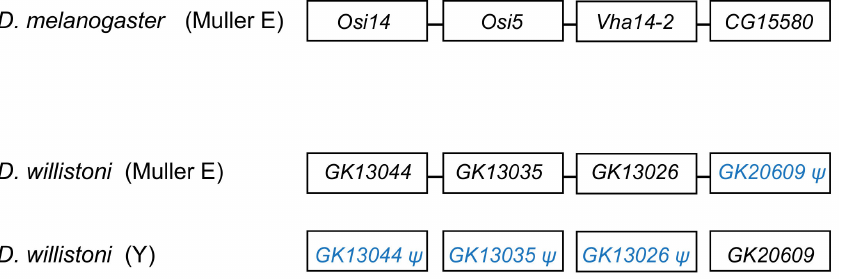
Figure 4. Fate of genes in the CH964272 segmental duplication. The segmental duplication copied 265 kb of autosomal sequence containing 25 genes to the Y chromosome of D. willistoni (for the sake of simplicity, the figure shows only four genes and omits several intervening ones). The Y- linked copy of GK20609 ( D. melanogaster ortholog: CG15580 ) remained functional, and the remaining 24 genes disappeared or became pseudogenes, whereas the opposite happened in the autosomal region. CG15580 / GK20609 and Vha14-2 / GK13026 are testis-specific genes in both species. The D. willistoni autosomal region is syntenic with D. melanogaster chromosome 3R (Muller E element). Gene order is unknown in the Y chromosome copy because it suffered duplications and deletions and the assembly is